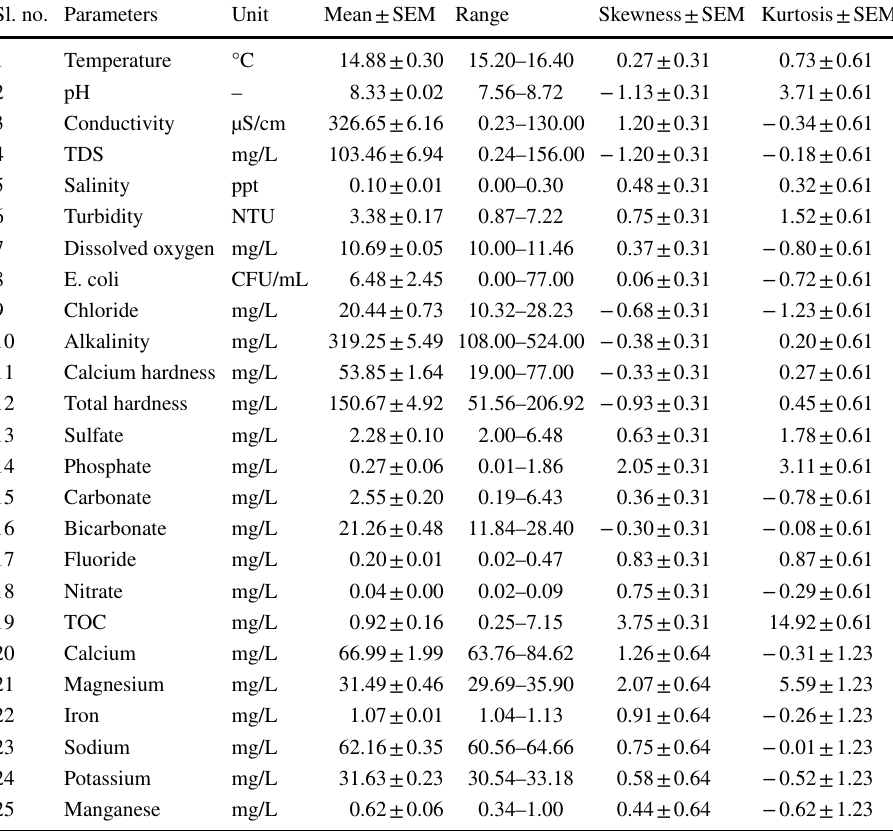
statistics of river water physicochemical and minerals of winter